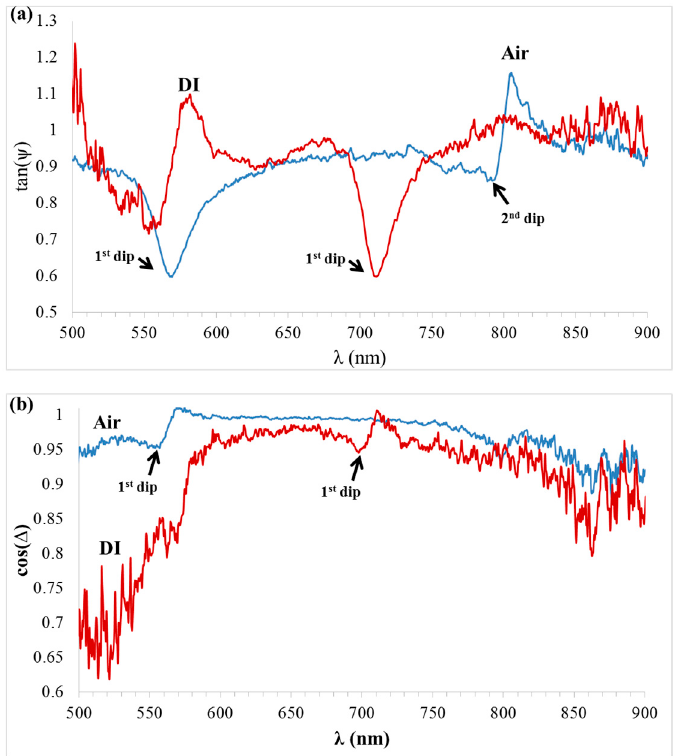
Figure 18. Demonstration of phase detection using CD-R and polarimetric functions ( a ) tan( ψ ) and ( b ) cos( Δ ) response for air and DI analytes under TM polarization.